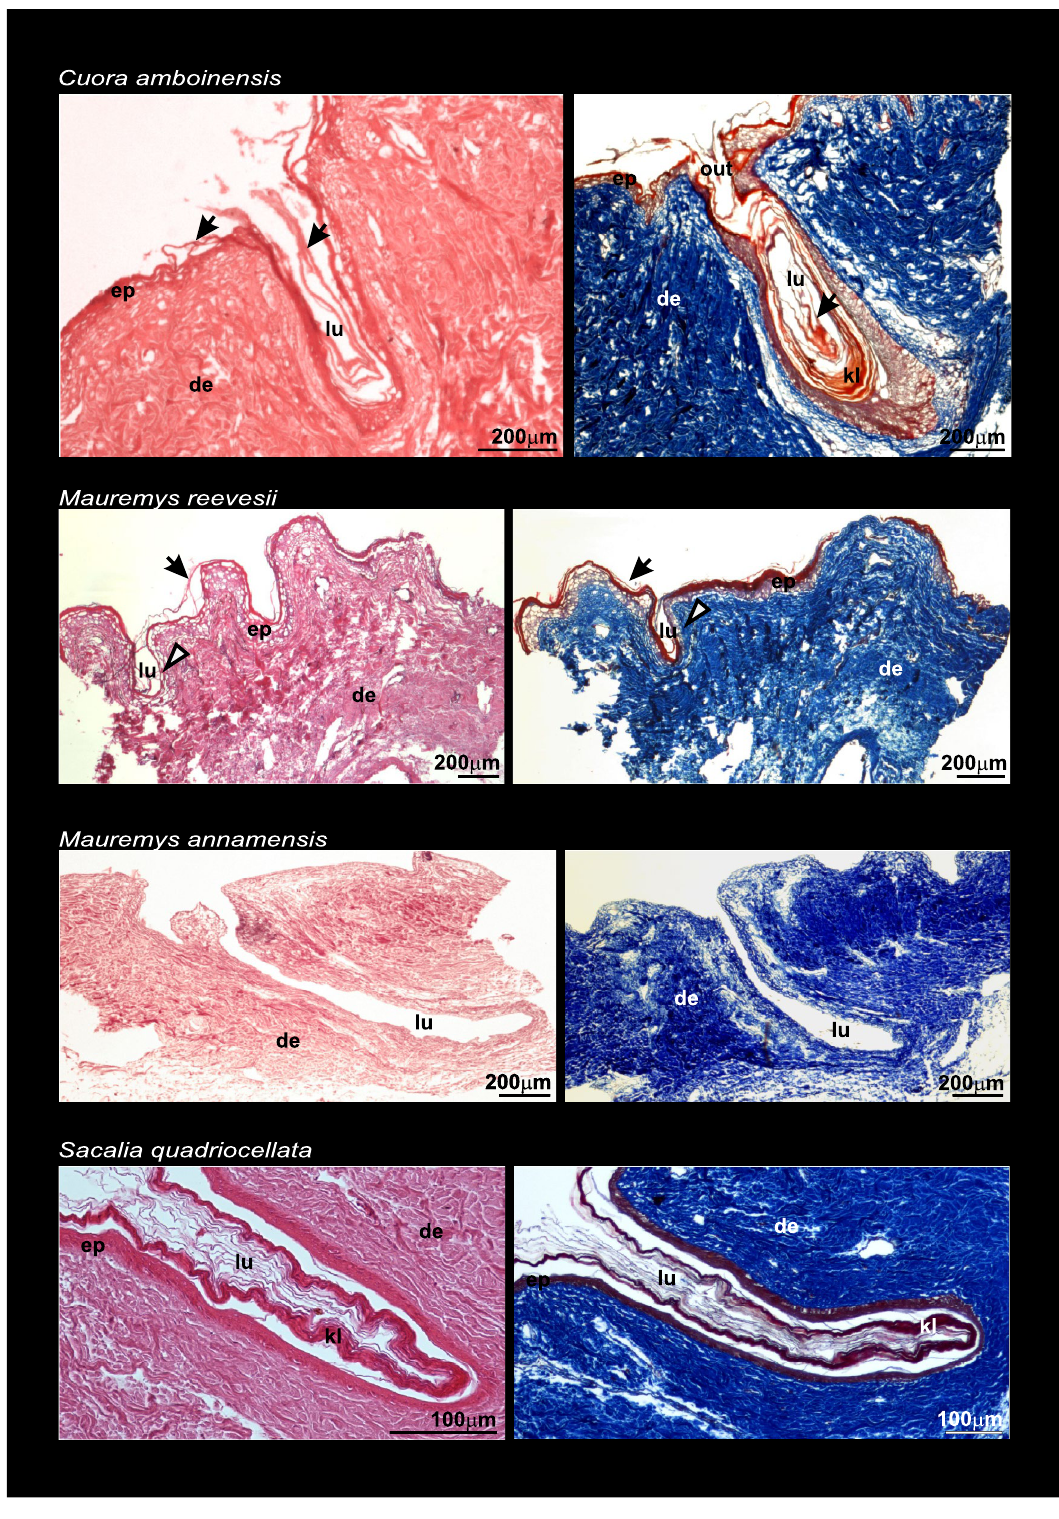
Figure 4. Histological plate showing mental gland structure in females of four species of geoemydid turtles. Staining techniques are Haematoxylin Eosin (left) and Mallory’s Trichrome (right). Arrows point to the keratinized layer (red color). Arrowheads point to a very small invagination in Mauremys reevesii (a likely vestigial form of MGs). In M. annamensis, the tissue shows signs of degradation such as the lack of a keratinized layer. Abbreviations: de, dermis; ep, epidermis; kl: keratinized layer; lu, lumen; out, outlet of the